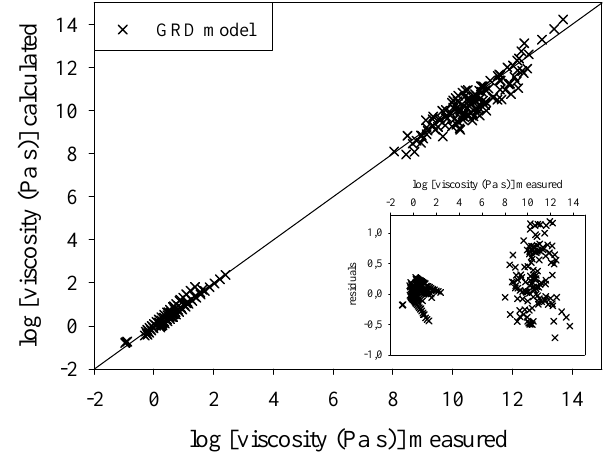
Fig. 3. Calculated vs measured viscosities for SiO 2 -undersaturated natural melts (SiO 2 in the 40–50wt% range): Witthington et al., 2000, 2001 (basanitic – NIQ –and tephritic compositions); Giordano and Dingwell, 2003a, b (Eifel basanite; Etna trachy- basalt; Vesuvius phonotephrite); Dingwell et al., 2004 (Balmuc- cia peridotite); Bouhifd et al., 2004 (Stein Frenz tephrite and phonotephrite); Sato, 2005; Ishibashi and Sato, 2007; Giordano et al., 2006, 2007, 2008, 2009 (Slapany basanite, Nyiragongo phoidite, Stromboli materials, 1906 Vesuvius eruption tephrite); Villeneuve et al., 2009; Ishibashi, 2009. The calculations are based on the Giordano et al. (2008) (GRD) model and reproduce high tem- perature (close to eruptive temperature) and low temperature (close to glass transition) data with less than 0.35 log units RMSE (Root Mean Standard Error). Accuracy of the predictions at close to erup- tive temperature is significantly higher, with RMSE less than 0.2 log